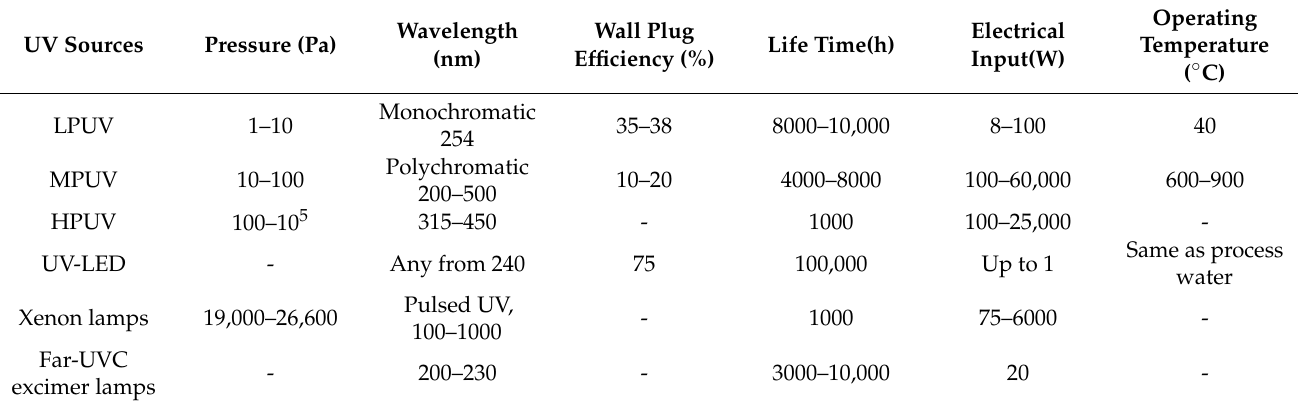
Table 1. Artificial UV sources and their